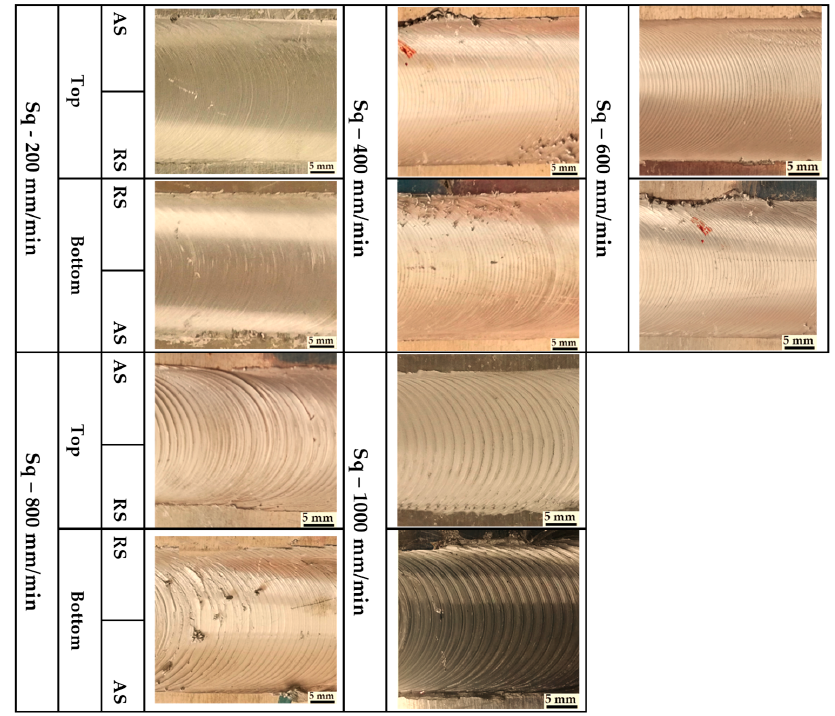
Figure 12. Top and bottom views of BT-FSW joints using Sq pin.